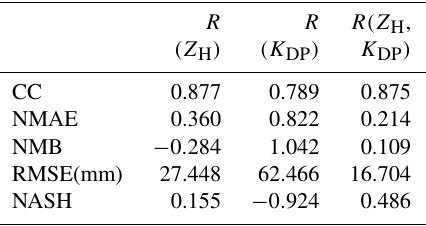
Table 7. Verification of the radar-based rainfall monthly accumula- tion products of Estonia. Z H is not corrected for attenuation.